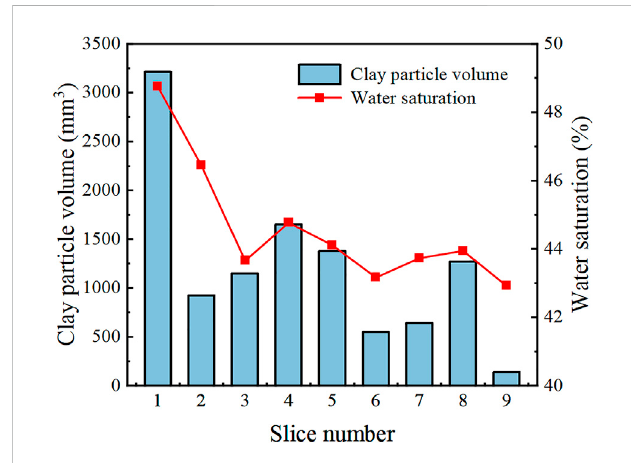
FIGURE 12 Thewatersaturationsandclayparticlevolumesatdifferentposition of